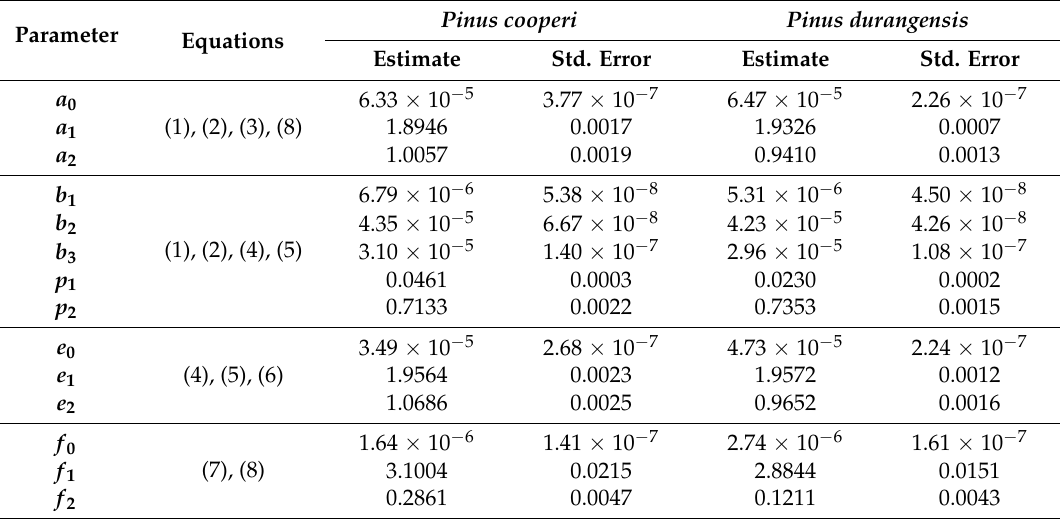
Table 3. Parameters for simultaneous fitting of the equation